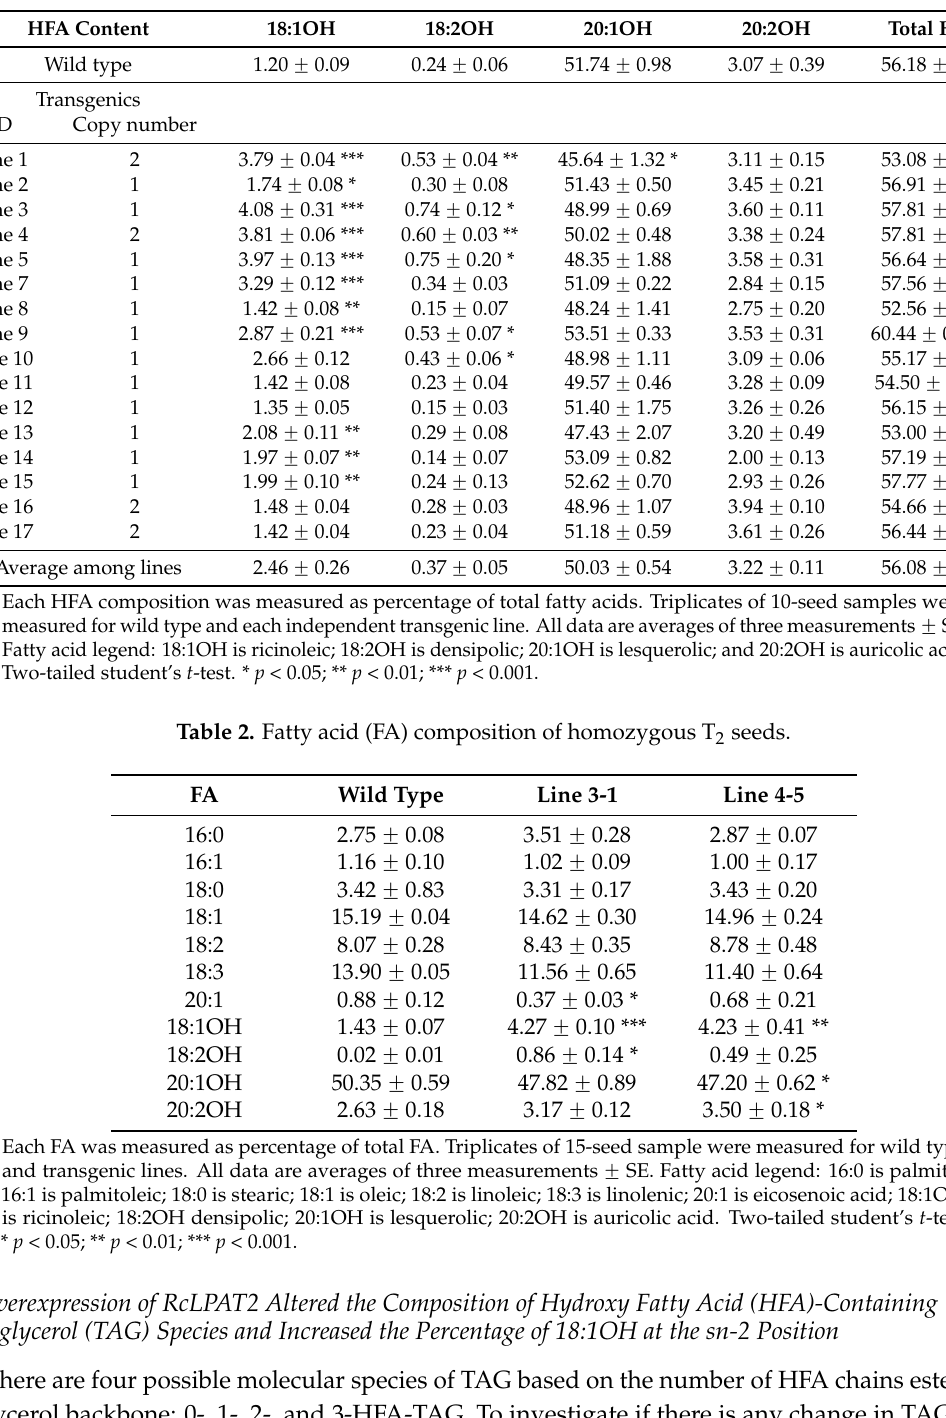
Table 1. RcLPAT2 copy number in primary transgenic lines and hydroxy fatty acid (HFA) composition of T 1 seeds.